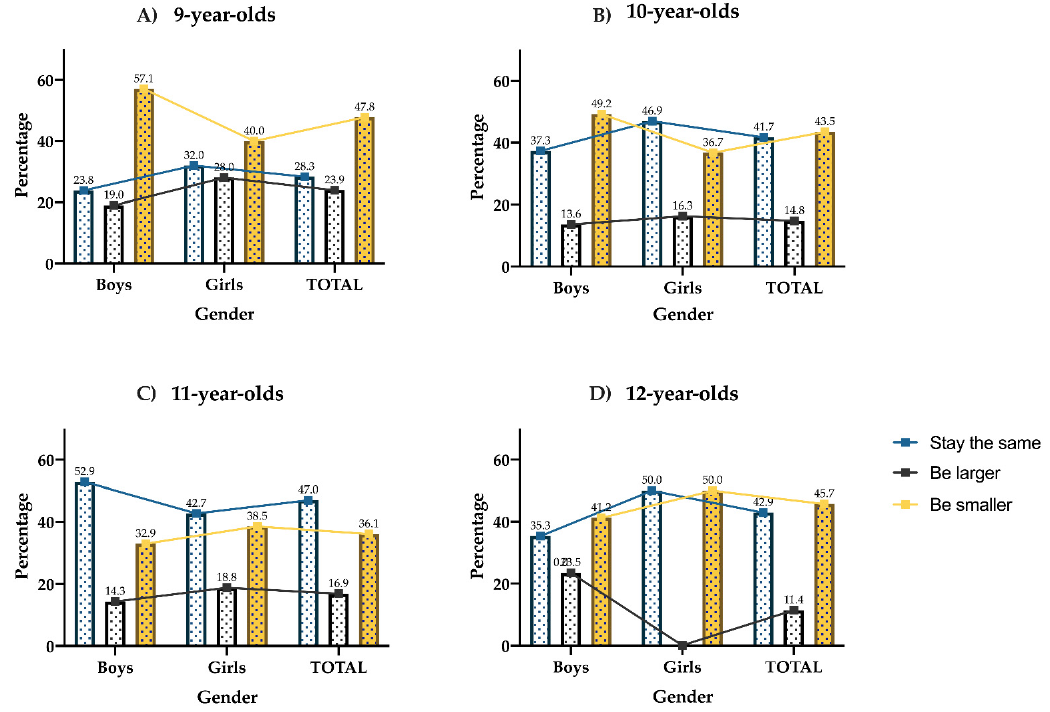
Figure 2. Desire to stay the same, be larger, or smaller of all schoolchildren who participated in this research and according to age. ( A ) 9 ‐ year ‐ olds; ( B ) 10 ‐ year ‐ olds; ( C ) 11 ‐ year ‐ olds; ( D ) 12 ‐ year ‐ olds, and gender (boys and girls).